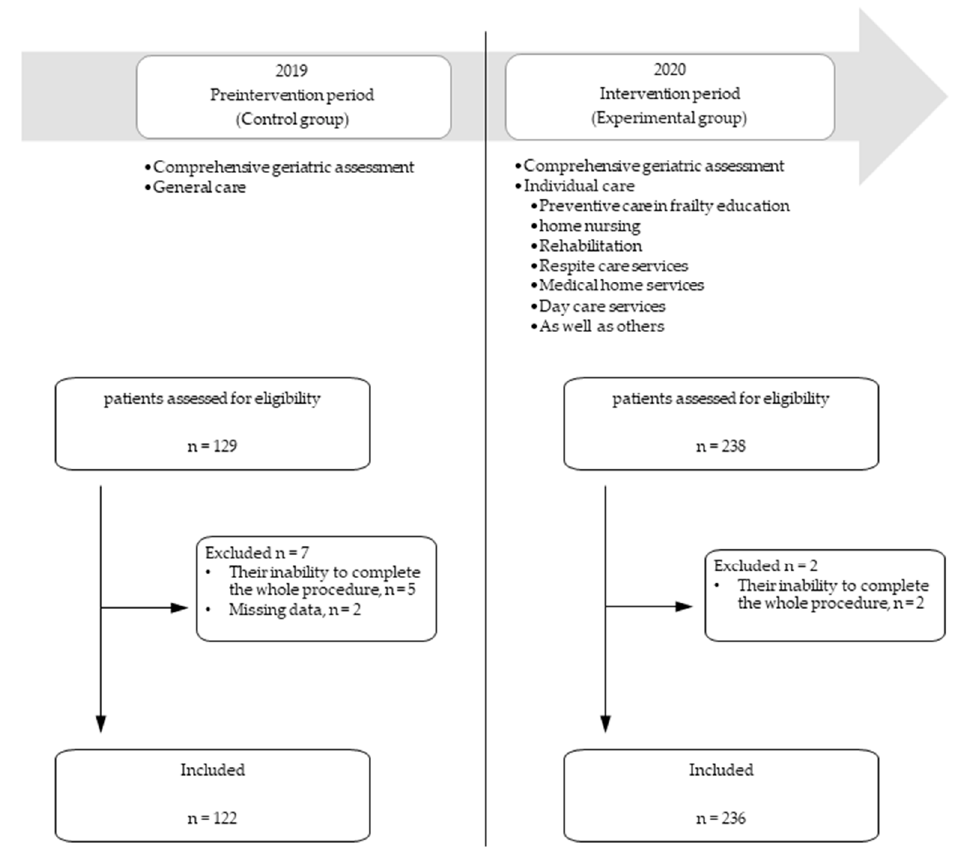
Figure 1. Overview of the implementation process and data collection periods.